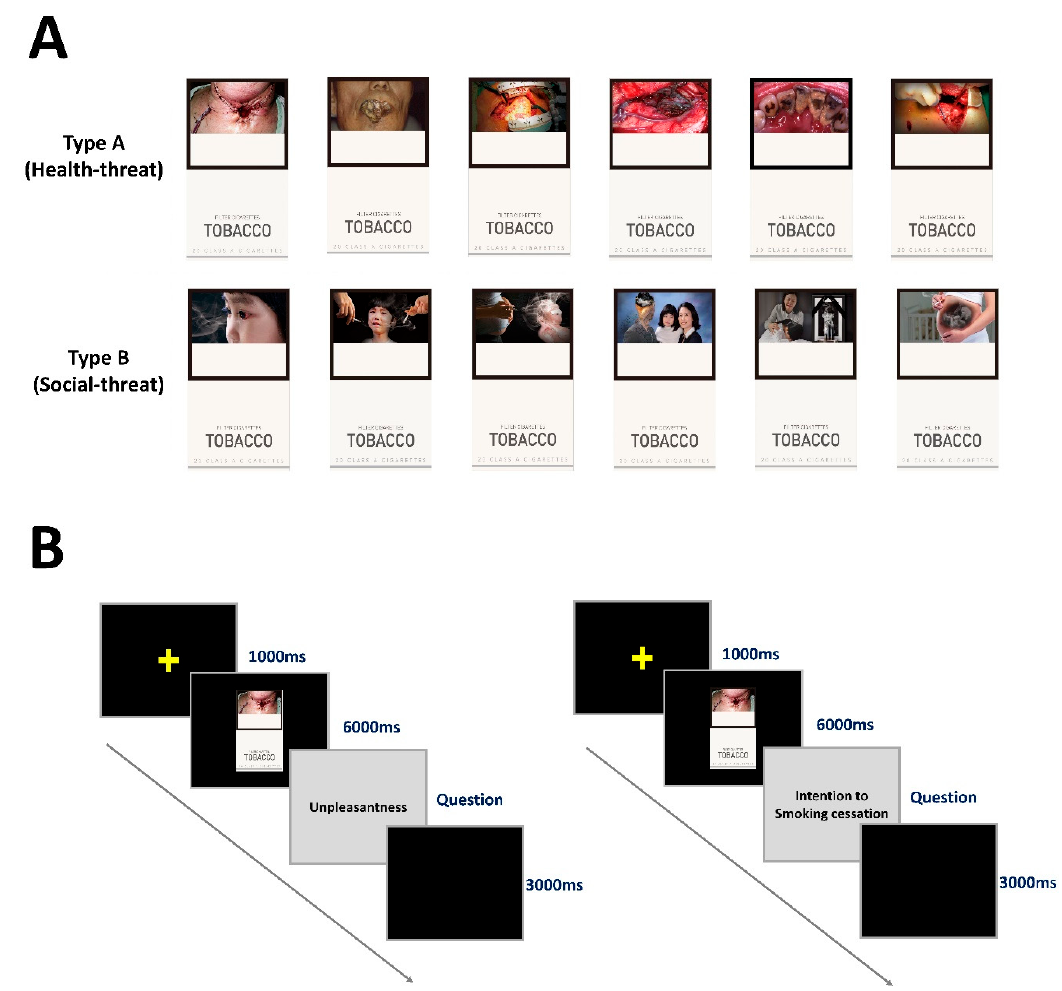
Figure 1. Experimental design and procedures. ( A ): There were 12 visual stimuli, which were cigarette packs with graphic health warnings (GHWs), including health-related threat images (H-GHWs) and social-harm-related images (S-GHWs). ( B ): The unpleasantness of the GHWs images was measured in the first session, and eye movements were recorded simultaneously. The intention to quit smoking in smokers or to remain as a non-smoker in non-smokers was evaluated in the second session.